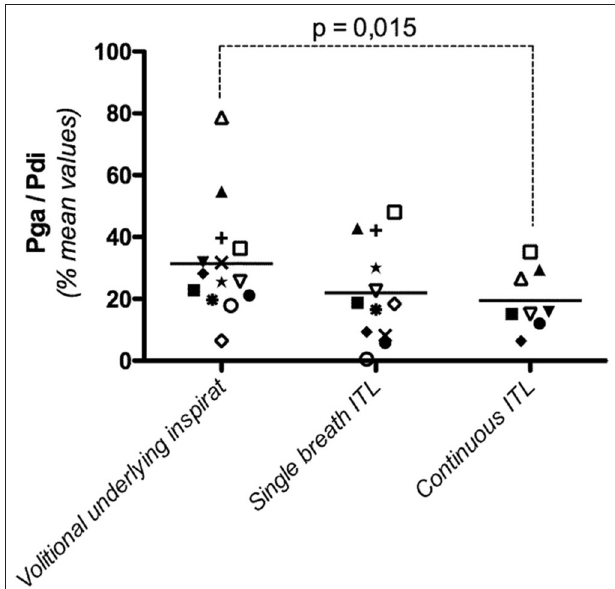
FIGURE 3 | Diaphragmatic contribution to the inspiratory effort produced to trigger the cervical magnetic stimulation (Pga/Pdi, with Pga: gastric pressure and Pdi: transdiaphragmatic pressure) during a voluntary effort, a non-volitional “single-breath” effort in response to the first presentation of an infinite resistance, and a non-volitional “continuous” effort, 10 breathing cycles after application of an inspiratory threshold load. Each point represents the mean value of Pga/Pdi in one subject, irrespective of the intensity of the underlying effort. The horizontal lines depict the group mean